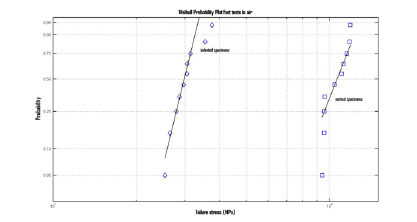
Figure 6: Weibull plot of fast tests in air on normal and indented specimens.